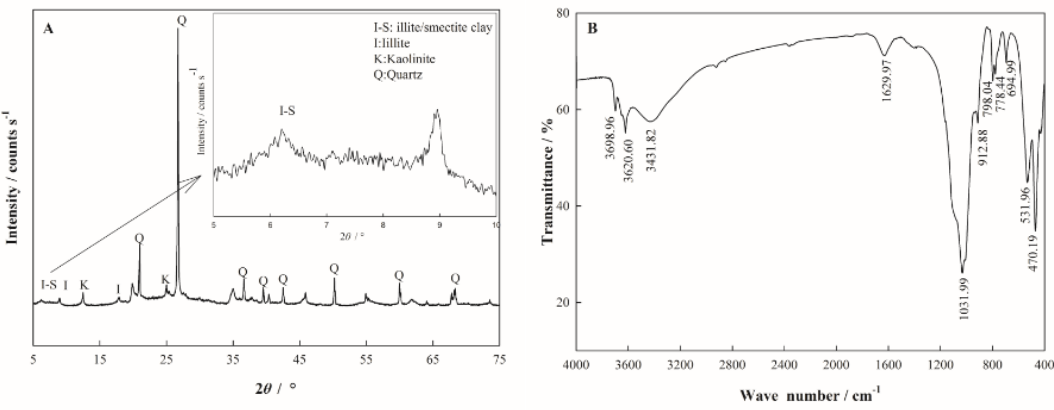
Figure 1. XRD spectra ( A ) and FT-IR spectrum ( B ) of nano I-S m .